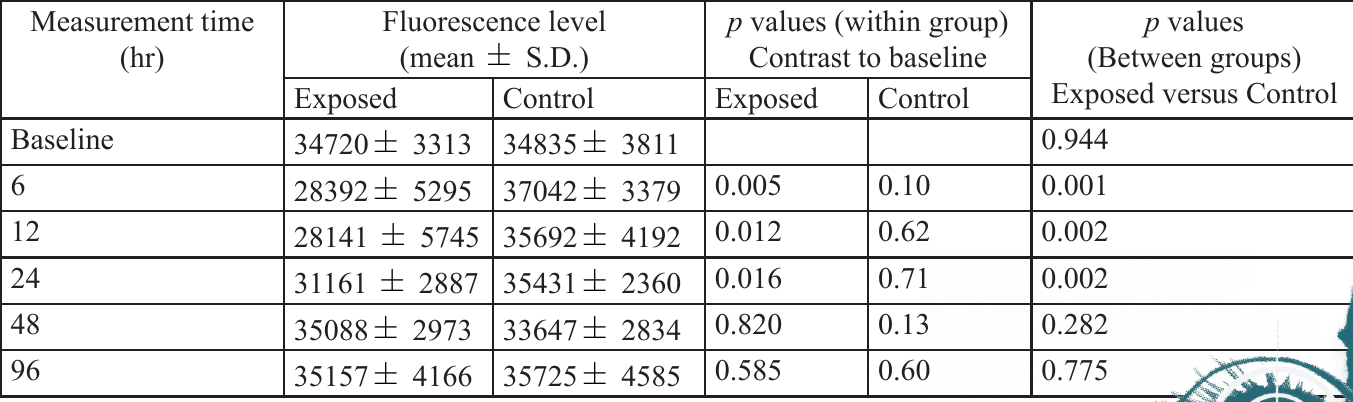
Table 3. Descriptive statistics of the fluorescence data for lenses exposed to ReNu multipurpose contact lens solution ( n = 10 for exposed lenses, and n = 10 for control